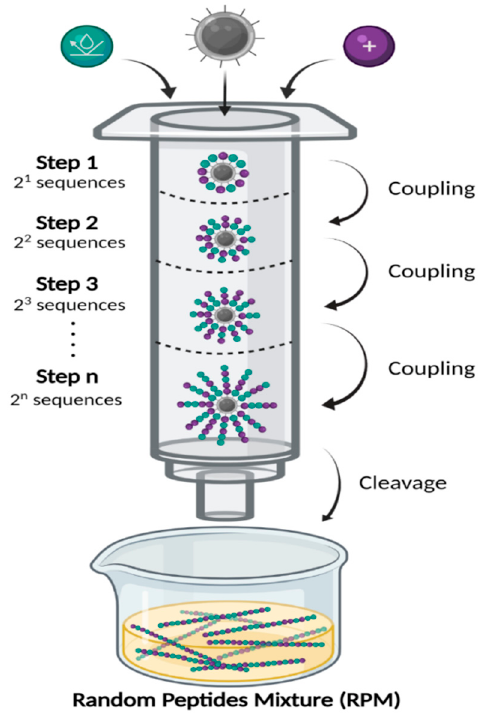
Figure 1. Random peptide mixtures (RPMs) synthesis. RPMs were synthesized using standard Fmoc-based solid-phase peptide synthesis (SPPS), on Rink amide resin (gray). Before each coupling step, the Fmoc protecting group was removed, then fresh solution containing 1:1 ratio of cationic (purple) and hydrophobic (cyan) protected amino acids was added. In each step there are 2 n optional peptide sequences (n = number of coupling steps). After the desired number of coupling steps, the peptides were cleaved from the solid support to generate free randomized linear peptides.